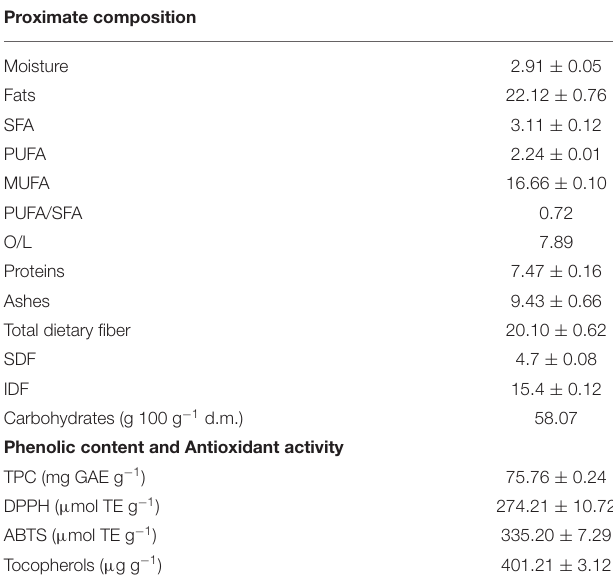
TABLE 2 | Chemical composition of the freeze-dried olive cake (g 100 g − 1 d.m.). Proximate composition Moisture